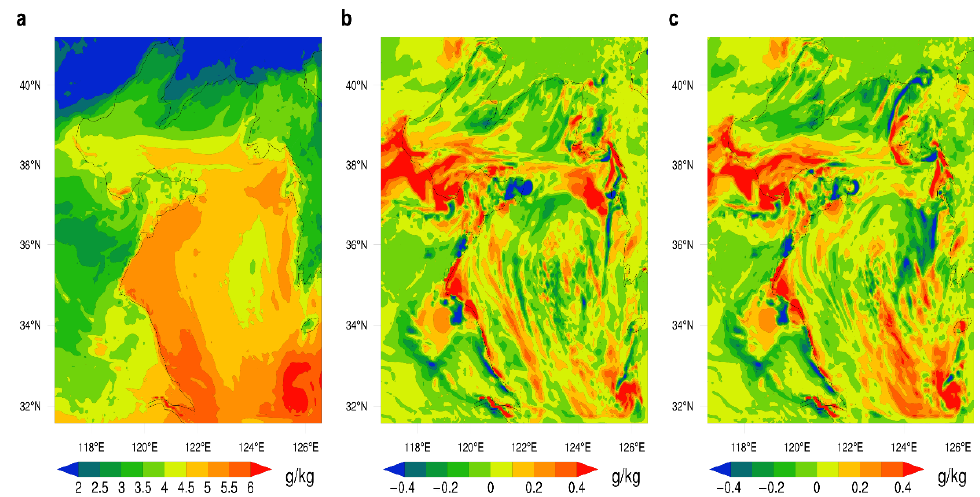
Figure 15. Specific humidity simulated using the 6h scheme and the difference compared with other schemes at 00:00 UTC on 20 February 2020. ( a ) 2-m specific humidity of the 6h scheme; ( b ) humidity difference between the 6h scheme and daily scheme; ( c ) humidity difference between the 6h scheme and FNL scheme.